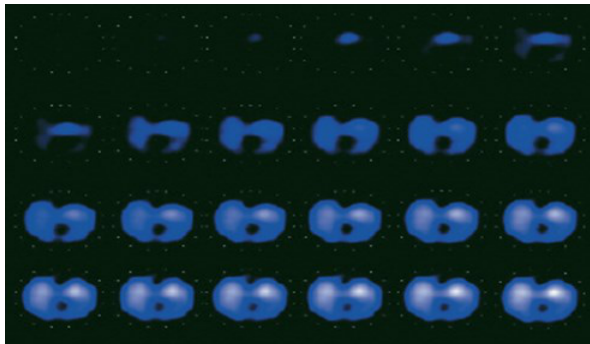
Fig. 6: Series of dynamic images showing air filling during inspiration by the PulmoVista500 system